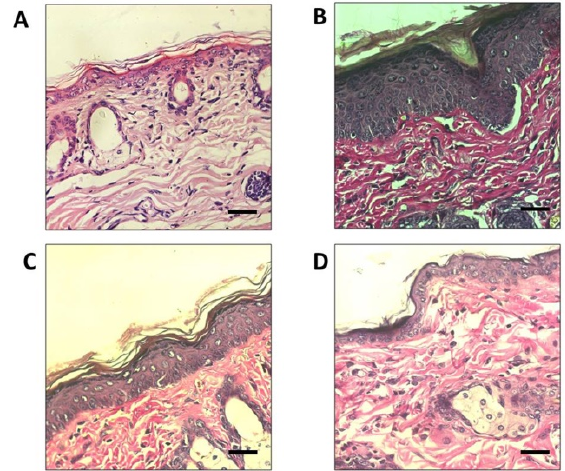
Figure 7. Histological analyses of mice skin irradiated by UV for two hours every day for seven days. ( A ) Control not irradiated with UV (Control − UV) ( B ) Control irradiated with UV (Control + UV) ( C ) Irradiated skin treated with 0.1% SC (SC + UV) ( D ) Irradiated skin treated with commercial product 30 SPF (CP + UV). Skin sections were stained with Van Gieson. Scale bars: 20 μm.